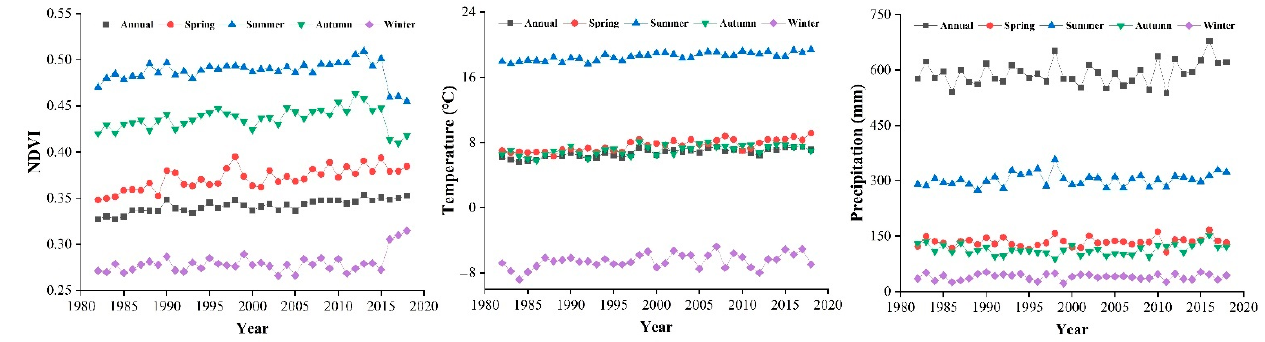
Figure 3. Variation of NDVI, temperature, and precipitation over the analysis period, 1982–2018.